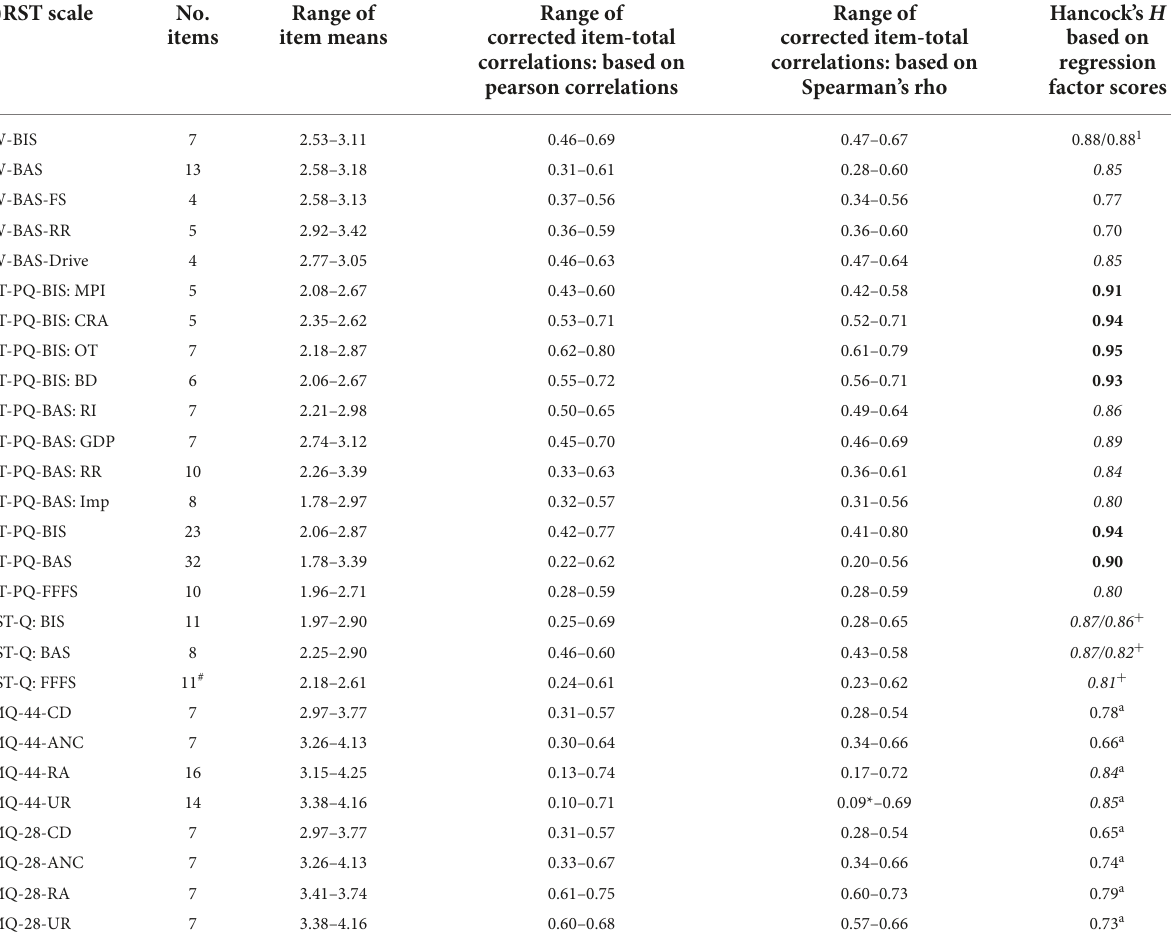
TABLE 3 Psychometric properties of the (r)RST subscales ( N = 1,076). (r)RST scale No.